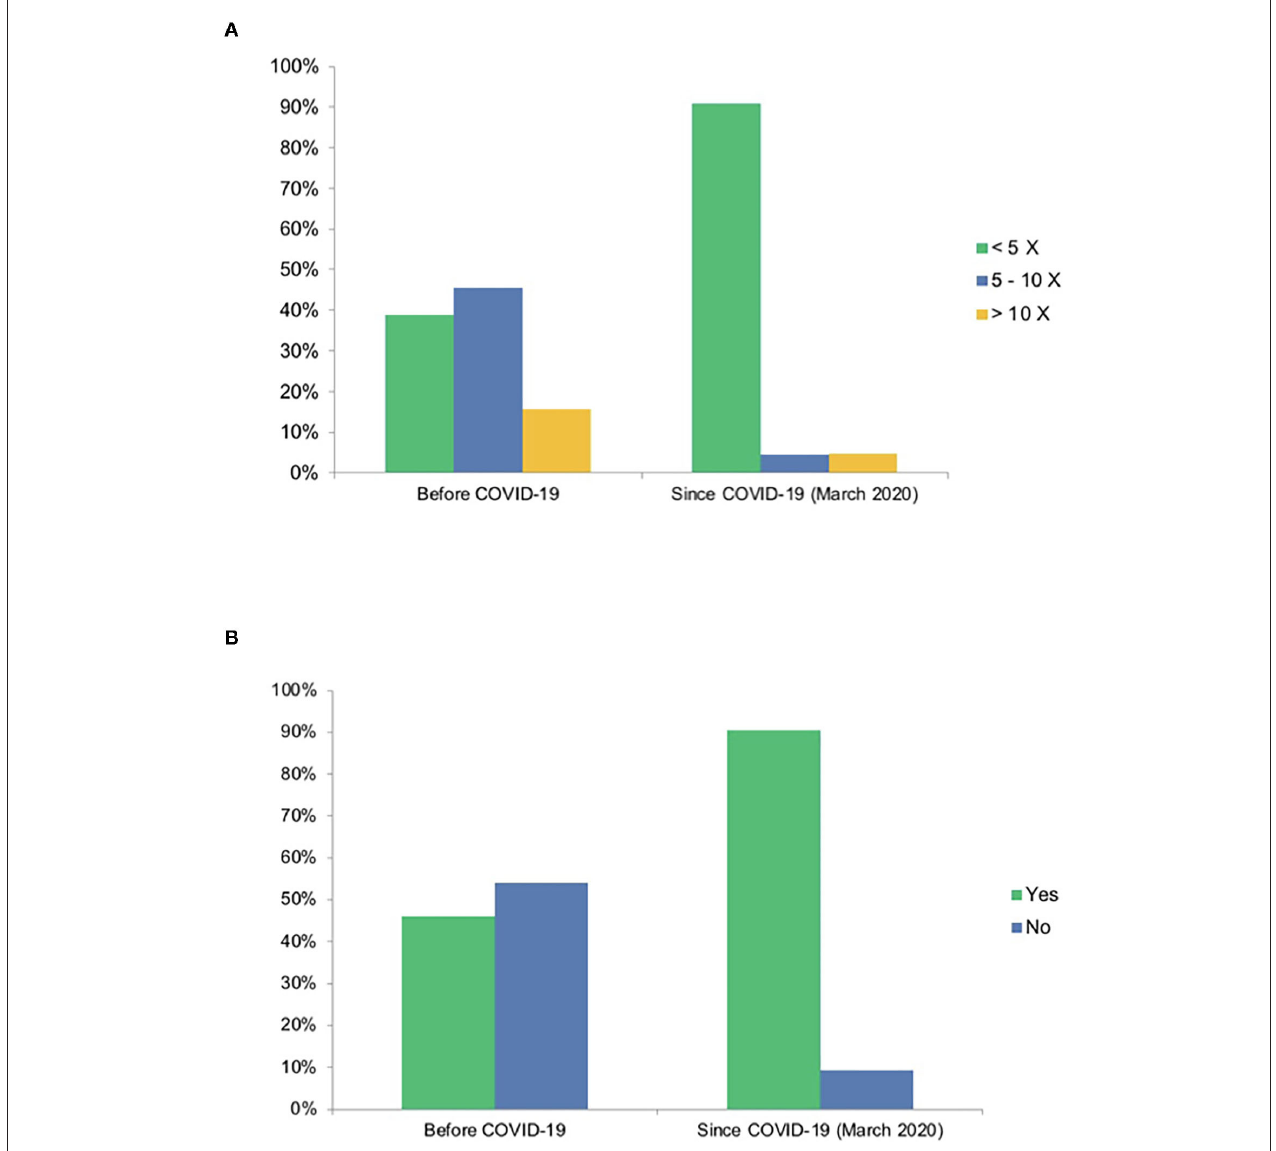
FIGURE 2 | Reported shift in medical education due to COVID-19. (A) Number of attended face-to-face events (percentage). (B) Attendance of online events (percentage). (A) A shift away from face-to-face events for continuing medical education was expectedly detected since the outbreak. (B) Also, a shift toward online events can be